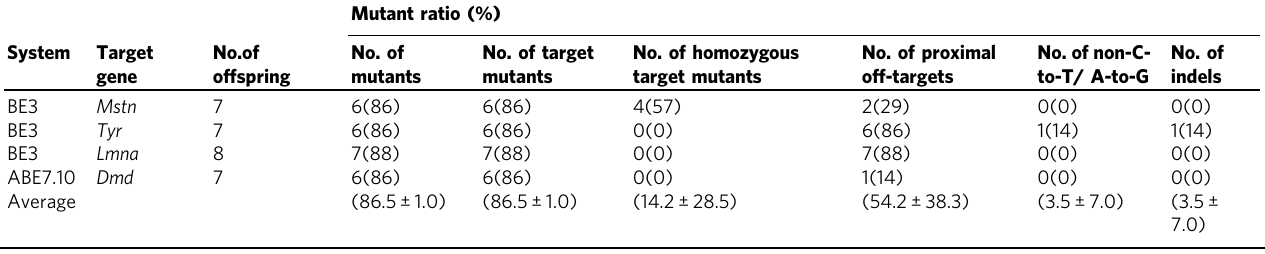
Table 2 Generation of base conversions in Founder rabbits using BE3 and ABE7.10 system